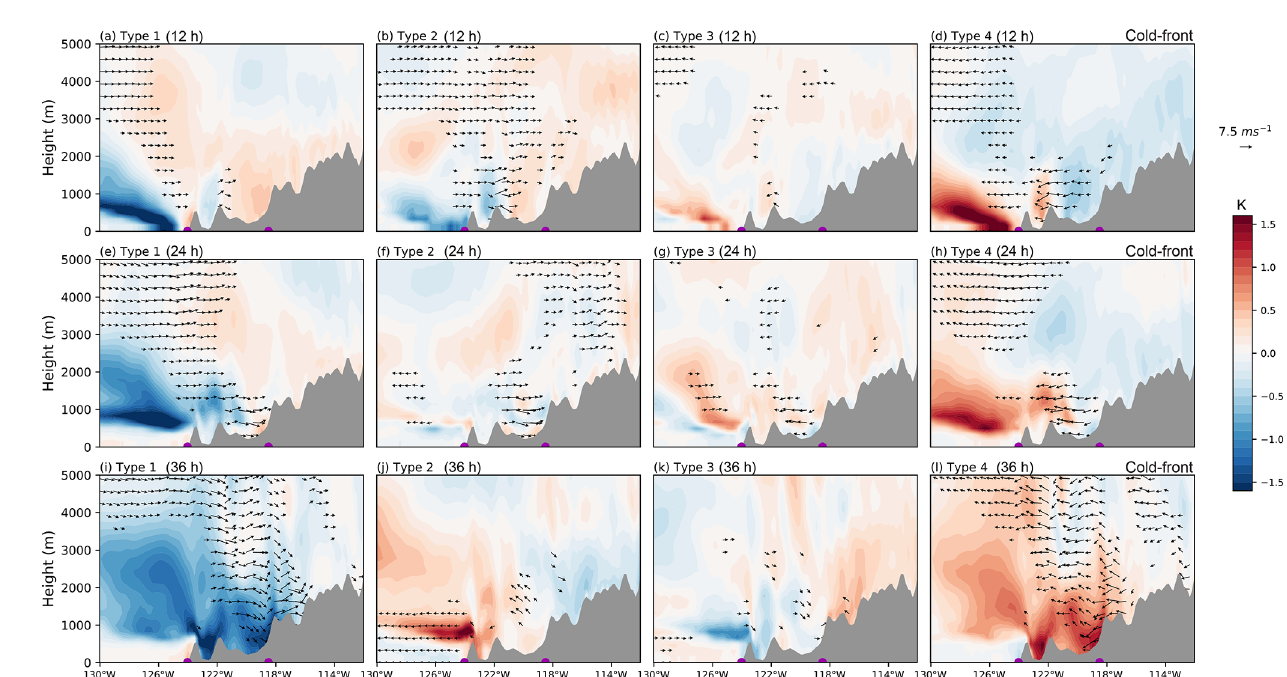
Figure 13. The same as Fig. 11, except for (a–d) 12h, (e–h) 24h, and (i–l) 36h during the cold-front case.